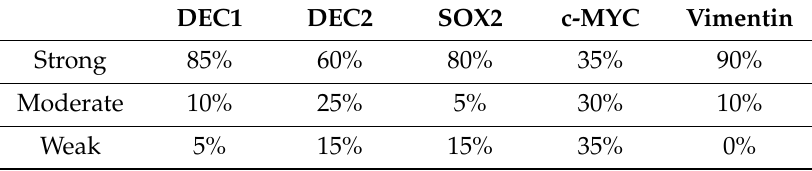
Table 4. Summary of immunohistochemical detection in tumor